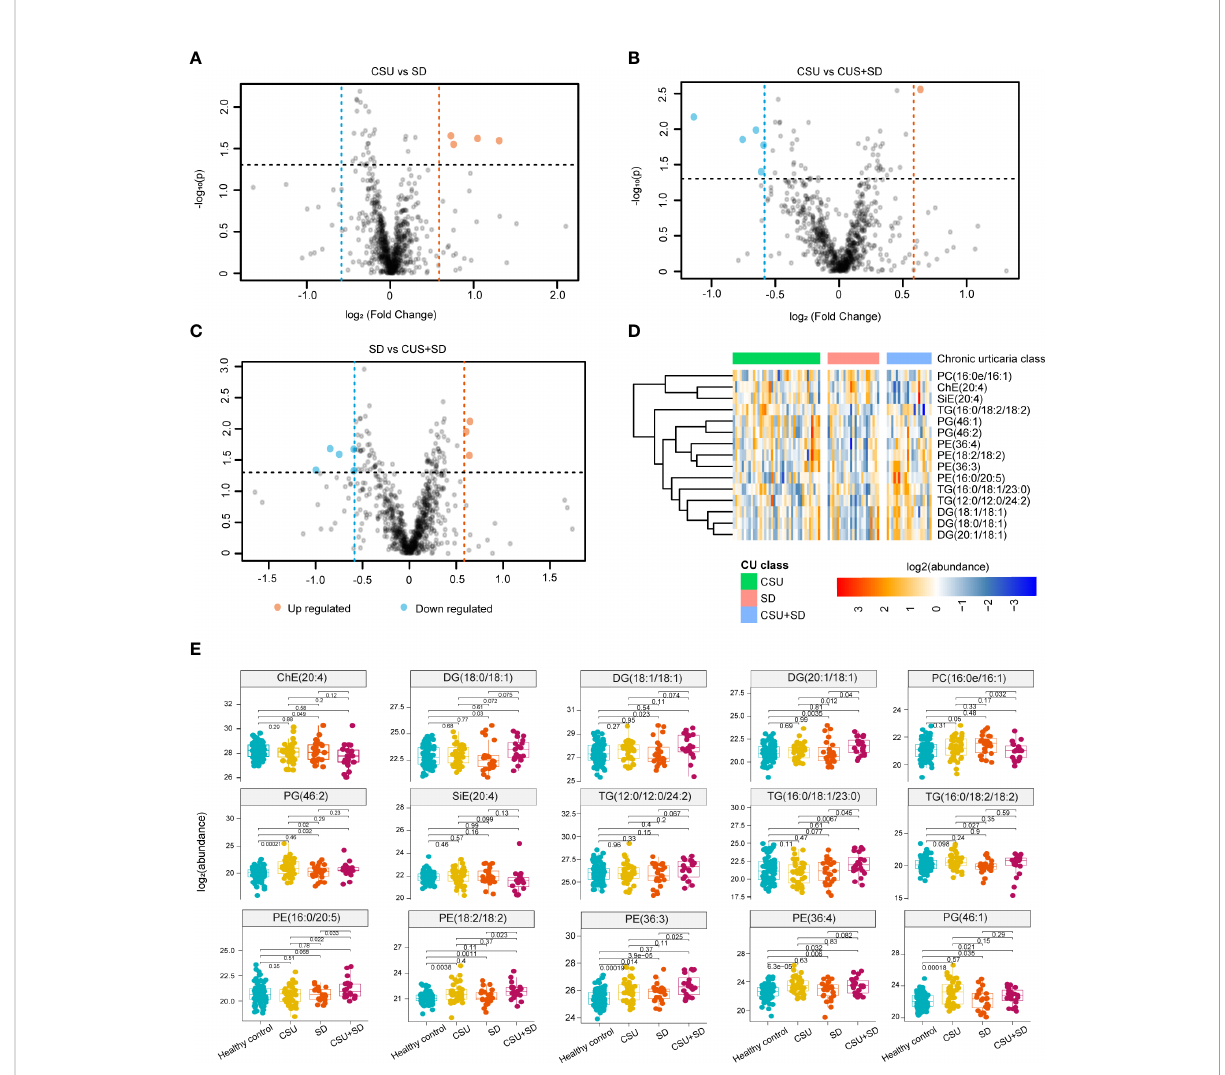
FIGURE 3 Identi fi cation of Lipid signatures in subtypes of CU. (A-C) Comparative analysis of lipid abundance between three groups of different types of urticaria as shown in the volcanic diagram. Blue represents the down-regulated lipid molecules, orange represents the up-regulated lipid, and non-signi fi cant lipid molecules are gray. (D) Heatmap of the top 15 differentially expressed metabolites. Different colors indicate different intensities, and colors range from blue to red, indicating strength from low to high. (E) Boxplot of the 15 signi fi cantly altered lipids. Blue represents the HC, yellow represents the CU, orange represents the SD, and purple presents the CSU+SD. The y-axis is the normalized intensity after log2